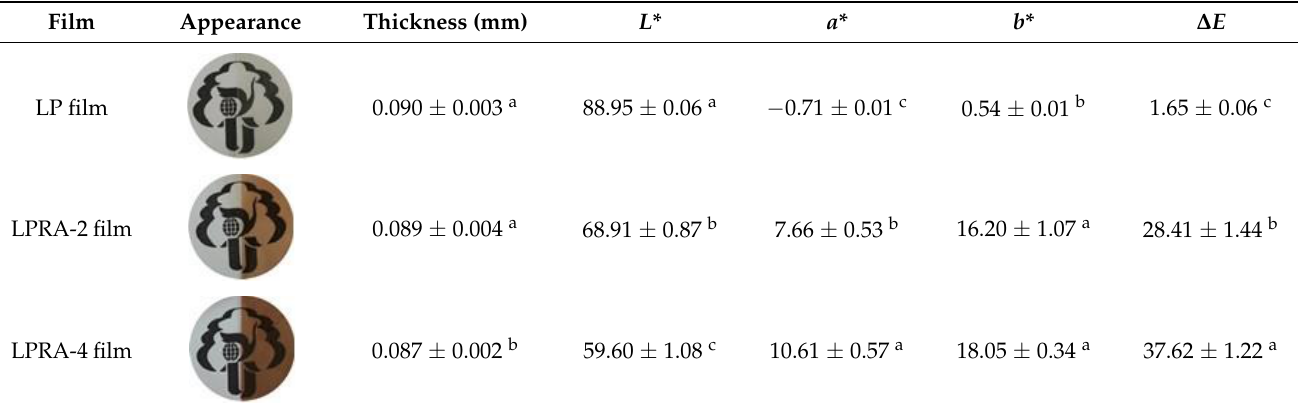
Values are given as mean ± standard deviation (n = 10 for film thickness, n = 3 for L *, a *, b *, and Δ E ). Different letters in the same column indicate significant difference ( p < 0.05). L *: lightness; a *: redness; b *: yellowness; Δ E : total color difference.